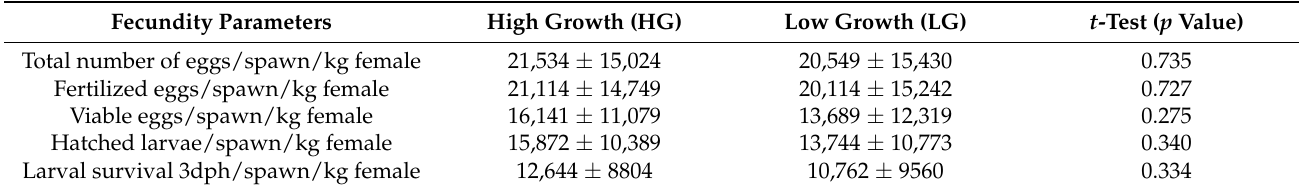
Table 5. Reproductive performance (fecundity) of gilthead seabream broodstock selected for high (HG) or low (LG) growth before experimental diet feeding period (HG, n = 56; LG, n = 54).